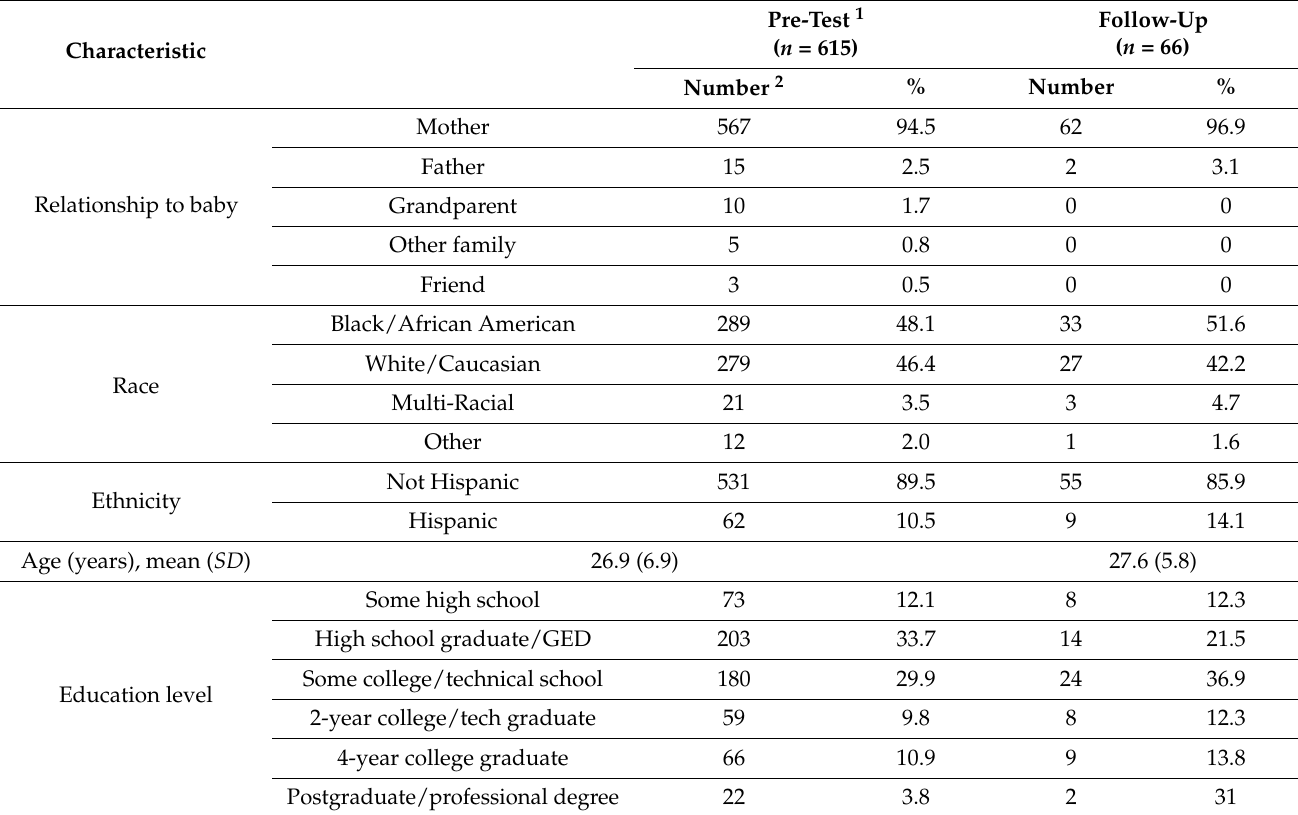
Table 1. Demographic